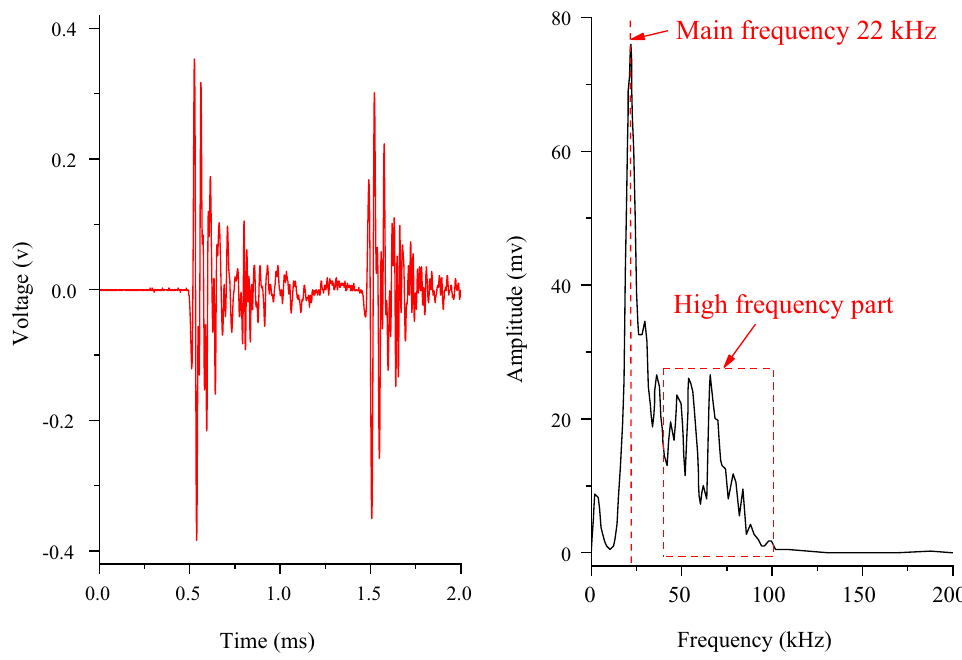
Fig. 5 Time domain and frequency domain characteristics in free